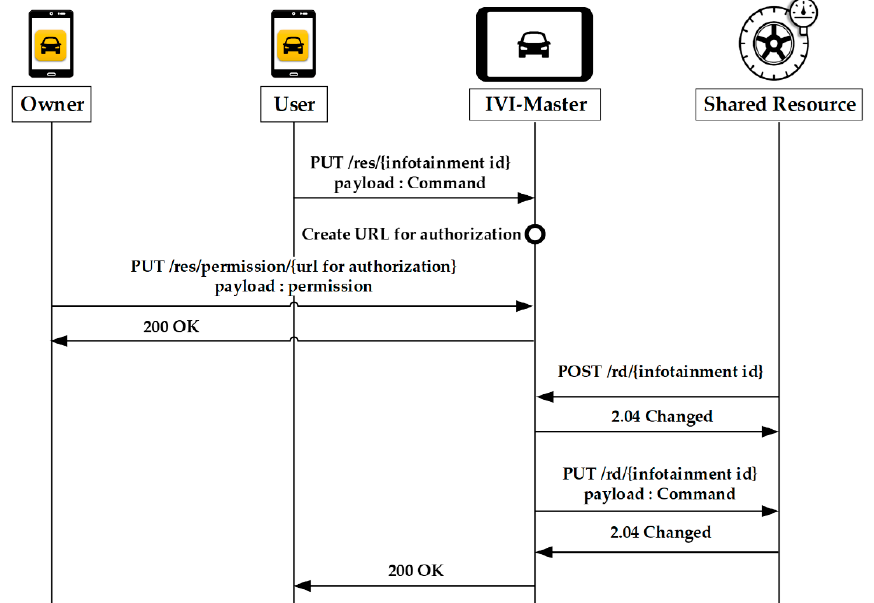
Figure 12. Control of shared resources by user.